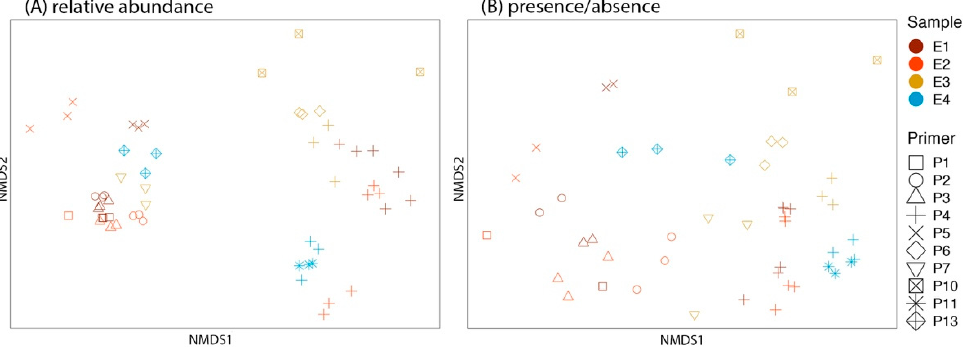
Figure 3. The nonmetric multidimensional scaling (NMDS) plot demonstrates the community composition of environmental samples (i.e., E1–E4) amplified by 10 primer sets. Each sample was run in triplicate. Community composition from ( A ) relative abundance data (stress = 0.174) and ( B ) pres- ence–absence data (stress = 0.173).